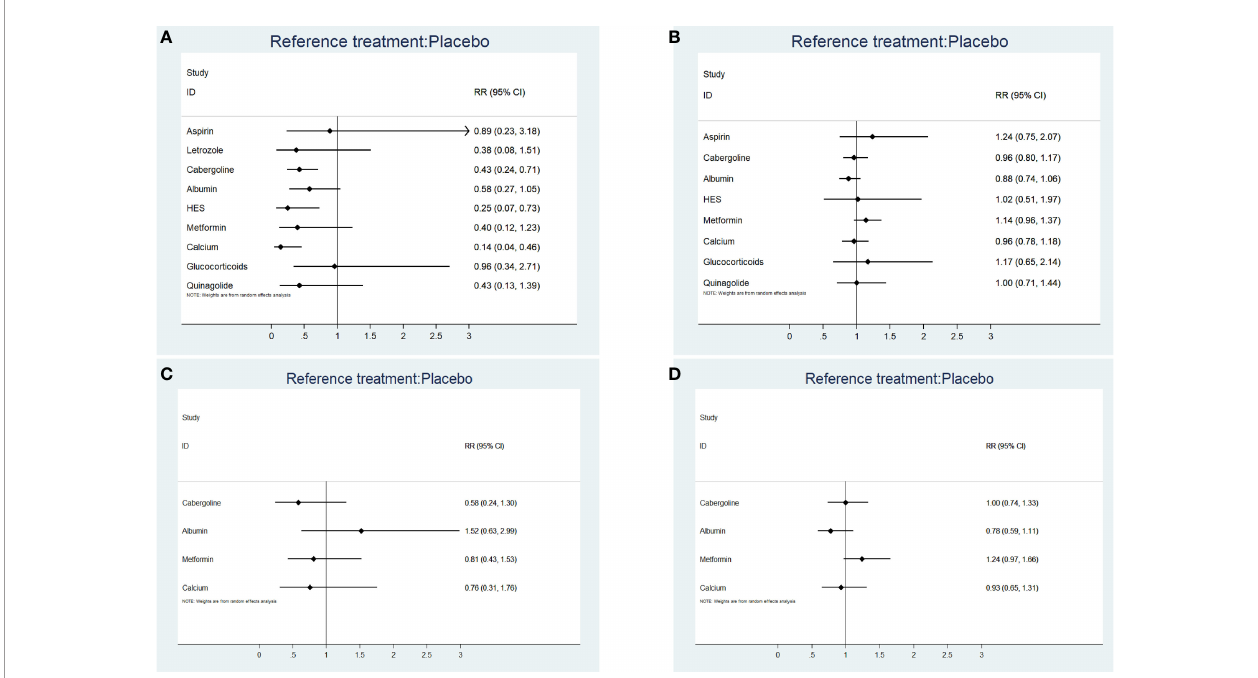
FIGURE 2 | (A) The forest plot for incidence rate of moderate-to-severe OHSS. (B) The forest plot for clinical pregnancy rate. (C) The forest plot for miscarriage rate. (D) The forest plot for live birth